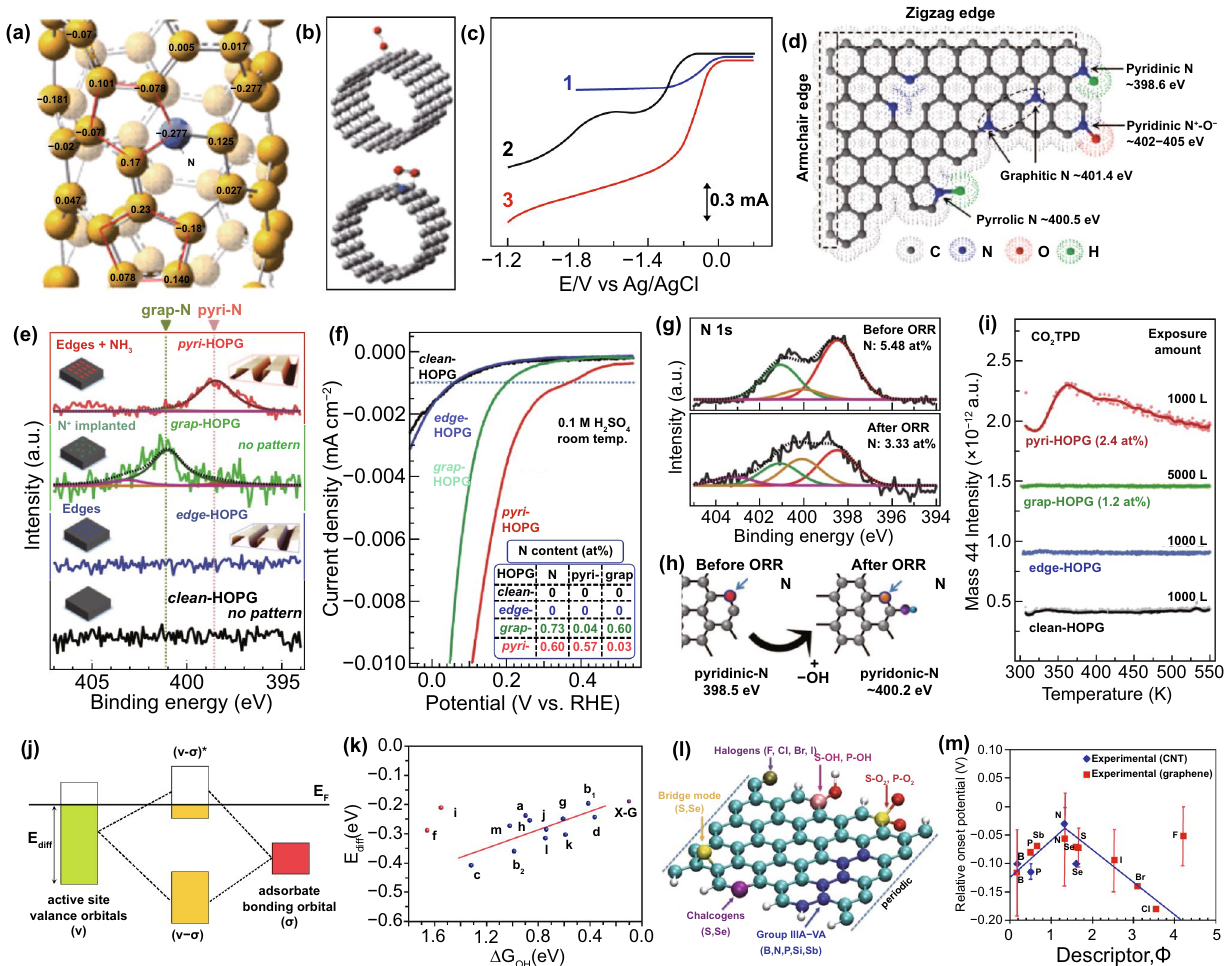
Fig. 2 Heteroatom-doped nanocarbon catalysts for ORR. a Calculated charge density distribution of the N-doped CNTs; b schematic illustra- tions of two possible adsorption modes of O 2 molecule at the pristine CNTs (top) and N-doped CNTs (bottom); c LSV curves for the prepared samples in air-saturated 0.1 M KOH for Pt/C (curve 1), VACCNT (curve 2), and VA-NCNT (curve 3) catalysts. Reproduced with permission from Ref. [3]. Copyright 2009, AAAS. d Schematic illustration of the commonly doped N species in carbon nanomaterials and the corresponded XPS binding energies. Reproduced with permission from Ref. [76]. Copyright 2015, AAAS. e , f N 1 s XPS spectra and the corresponded LSV curves of the electrocatalysts; the inset of f is the N contents of the catalysts; g N 1 s XPS spectra of the N-HOPG catalyst before and after ORR testing, respectively; h schematic illustrations of the formation of pyridinic-N by the attachment of OH to the carbon atom next to pyridinic-N. i CO 2 -TPD results for the four kinds of HOPG model catalysts. Reproduced with permission from Ref. [6]. Copyright 2016, AAAS; j scheme of orbital hybridization between the valance band of the doped carbon and the bonding orbital of adsorbates; k the relationship between Δ G OH* and E diff for various doped graphene (X–G) active sites; note that the red points were not fitted. Reproduced with permission from Ref. [81]. Copy- right 2014, American Chemical Society. l Schematic of various heteroatoms doped graphene nanoribbons. m Experimentally measured relative onset potential to that of Pt/C catalyst, as a function of descriptor ( Φ ) for p -element-doped carbon materials. Reproduced with permission